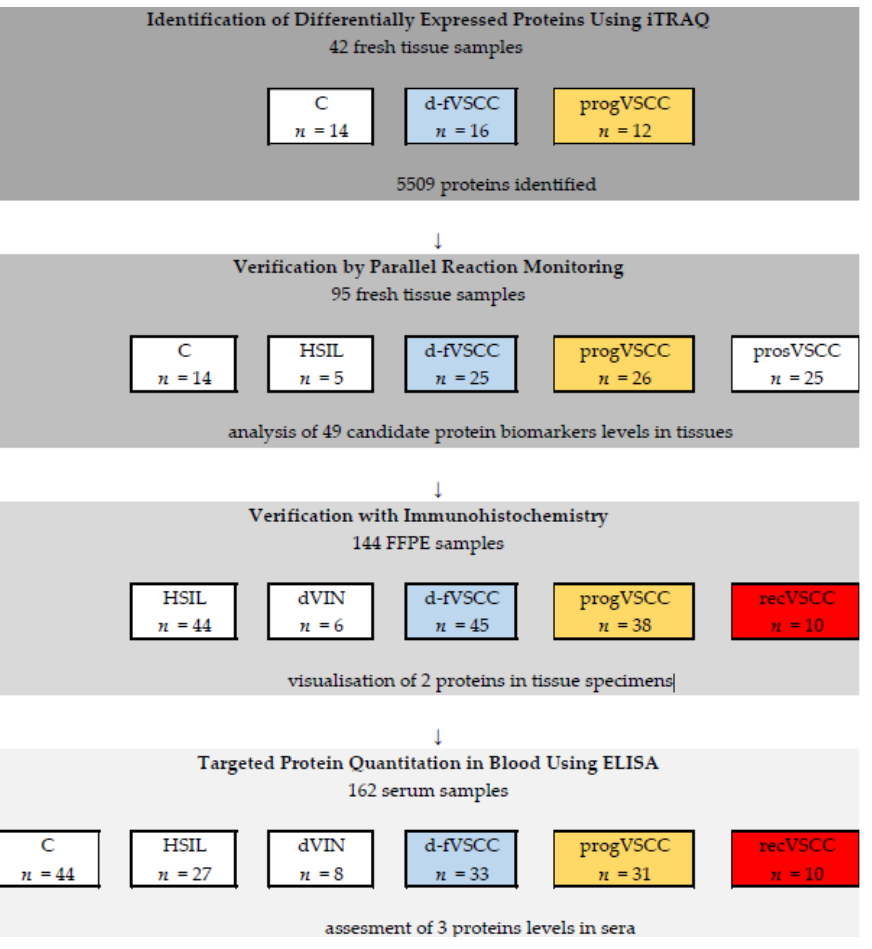
Figure 6. Study workflow from the discovery phase to protein selection and verification. Basic characteristics of patients with primary VSCC (i.e., those from d-fVSCC, prog- VSCC, and prosVSCC groups) included are shown in Table 2. Table 2. Demographic and clinical characteristics of the patients with primary VSCC. Numbers of samples are provided for the consecutive phases of the study. Characteristic